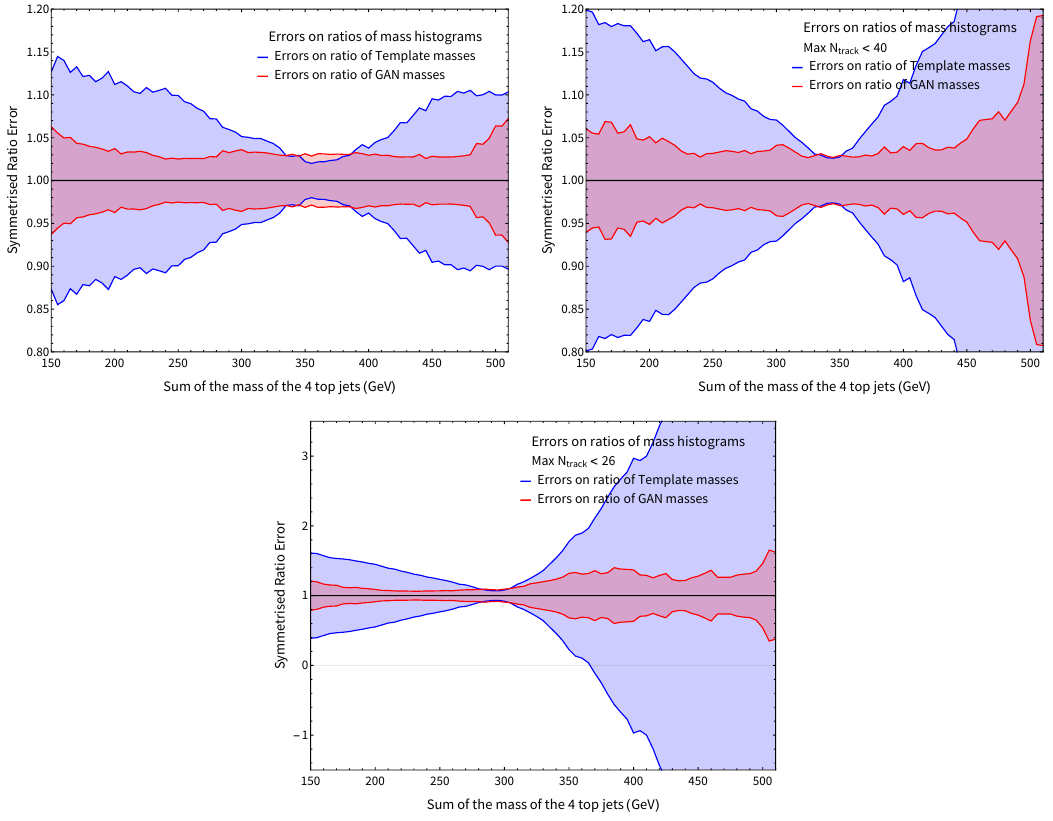
Figure 6 . Computing the ratio error of generated mass distributions ( P m J of the masses of the top 4 jets) to the real distribution, symmetrized by re(cid:13)ecting across the ideal ratio = 1, with statistical uncertainties included. Inclusive error measurements are shown on the top left, for the other plots a cut is placed on N track : where for N track < X all four jets of the events considered are required to have N track < X . As we reduce the e(cid:14)ciency of this cut, we see that the GAN’s relative performance to the template distributions becomes better-expected because the GAN learns how mass changes in N track . For the top right plot, the e(cid:14)ciency of the cut is 50% overall while for the bottom plot, the e(cid:14)ciency is about 50% per jet (about 6%